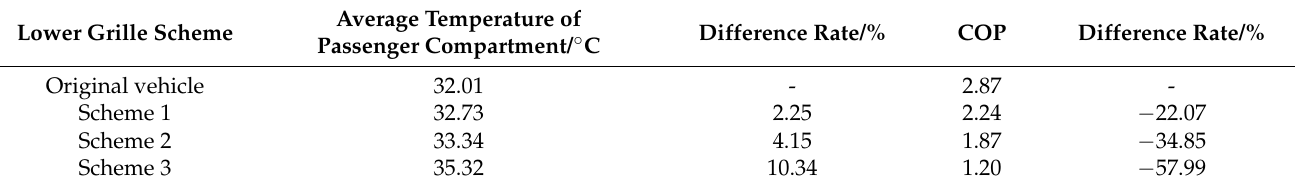
Table 9. Difference rate of the allowable ambient temperature under different schemes compared with the original vehicle.